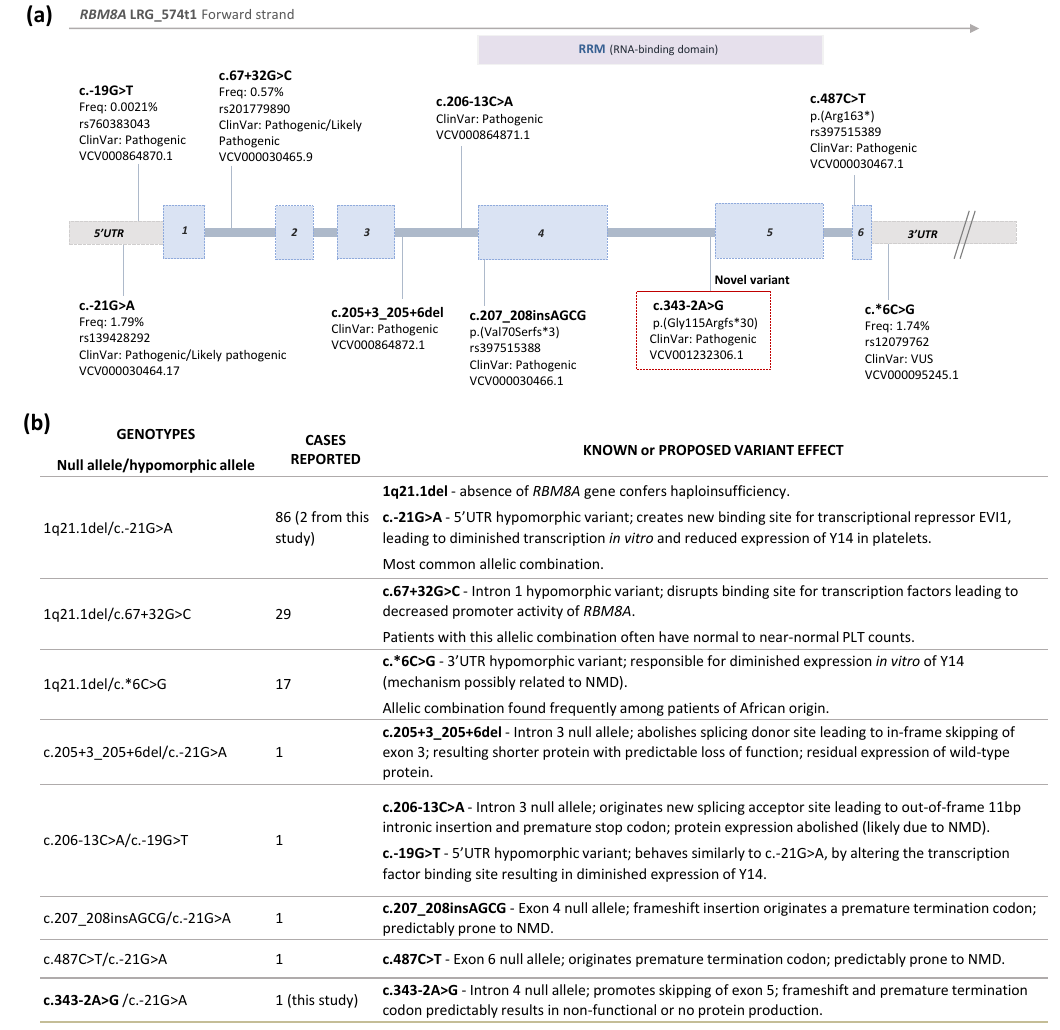
Figure 2. ( a ) Schematic representation of the RBM8A gene and the localization of TAR syndrome associated variants classified as pathogenic/likely pathogenic, as documented in the literature. The novel variant identified in this work is highlighted in a box. The nomenclature is used according to HGVS, using Reference Sequence NM_005105.4, LRG_574t1. When available, frequencies in the gnomAD database and dbSNP identification references are shown. Blue boxes—exons; grey boxes—UTRs; RRM—RNA recognition motif; VUS—variant of uncertain significance. ( b ) Summary of documented TAR syndrome genotypes and known/predicted effects of the variants. NMD— nonsense-mediated mRNA decay. Source